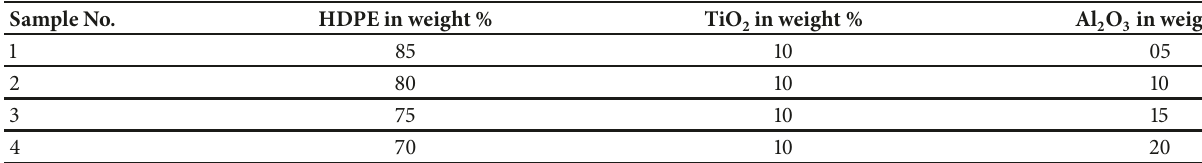
Table 1: Composition of composites prepared.